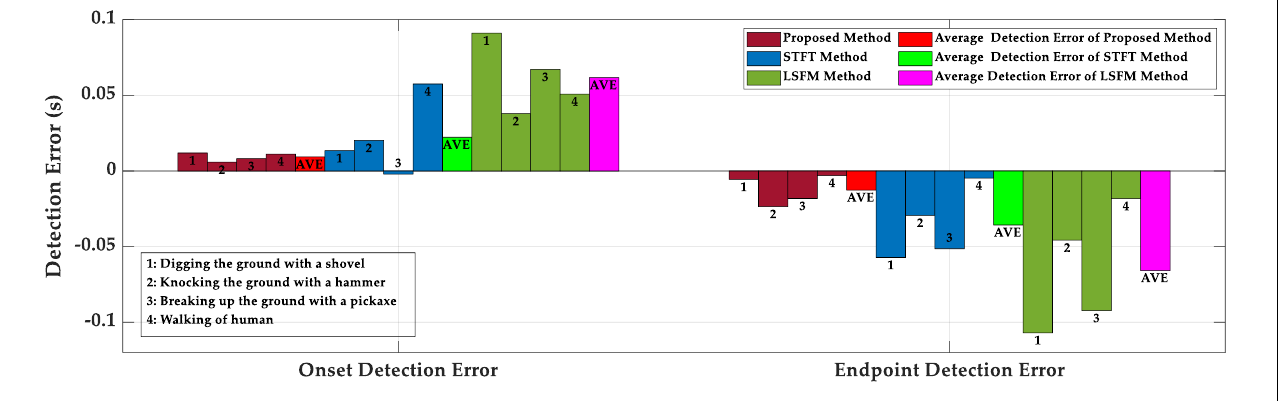
Figure 10. The detection onset and endpoint errors of the four kinds of signals for the proposed method, the LSFM method and the STFT method.